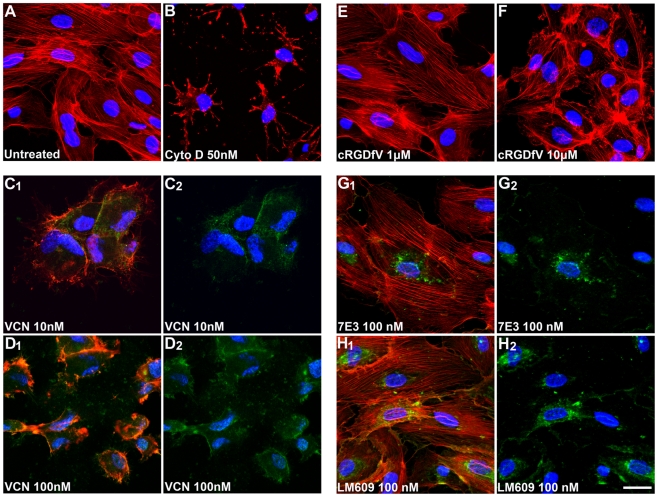
VCN induces massive actin cytoskeleton reorganization in HUVEC seeded on Matrigel.HUVEC were seeded in serum-free media in multiwell chamber slides on complete Matrigel, allowed to adhere, and then treated for 3 hr with various concentrations of cRGDfV peptide (1 and 10 µM) or FITC-VCN (10 and 100 nM) or the monoclonal antibodies 7E3 (100 nM) or LM609 (100 nM). When cells were incubated with integrin-binding antibodies (7E3 or LM609), a FITC-conjugated secondary antibody was used to track these treatments. The actin modifier Cytochalasin D was used as a positive control (50 nM). At the end of the incubation period, the cells from all conditions were fixed in 4% formaldehyde, permeabilized in 0.1% Triton X-100, stained with Rhodamine-Phalloidin and Hoechst 33342, and imaged by confocal microscopy. The cells exposed to FITC-labeled treatments (VCN or integrin-binding antibodies) are triple stained. The images shown above are Rhodamine-Hoechst only (panels A–B and E–F), FITC-Hoechst (panels C2-D2 and G2-H2) or overlayed three fluorophores (panels C1-D1 and G1-H1). Representative confocal images from multiple experiments taken at the same magnification (×630) are shown above (scale bar, 20 µm).